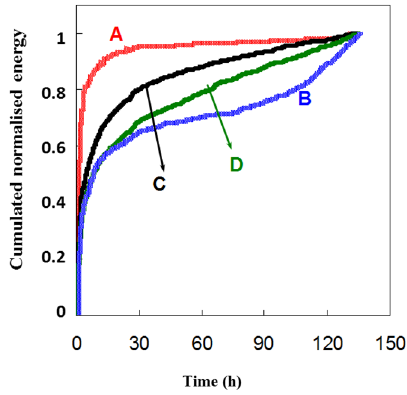
Figure 11. Activities of several clusters during static fatigue test at 500 °C and σ / σ R = 0.79. Appl. Sci. 2016 , 6 , 43